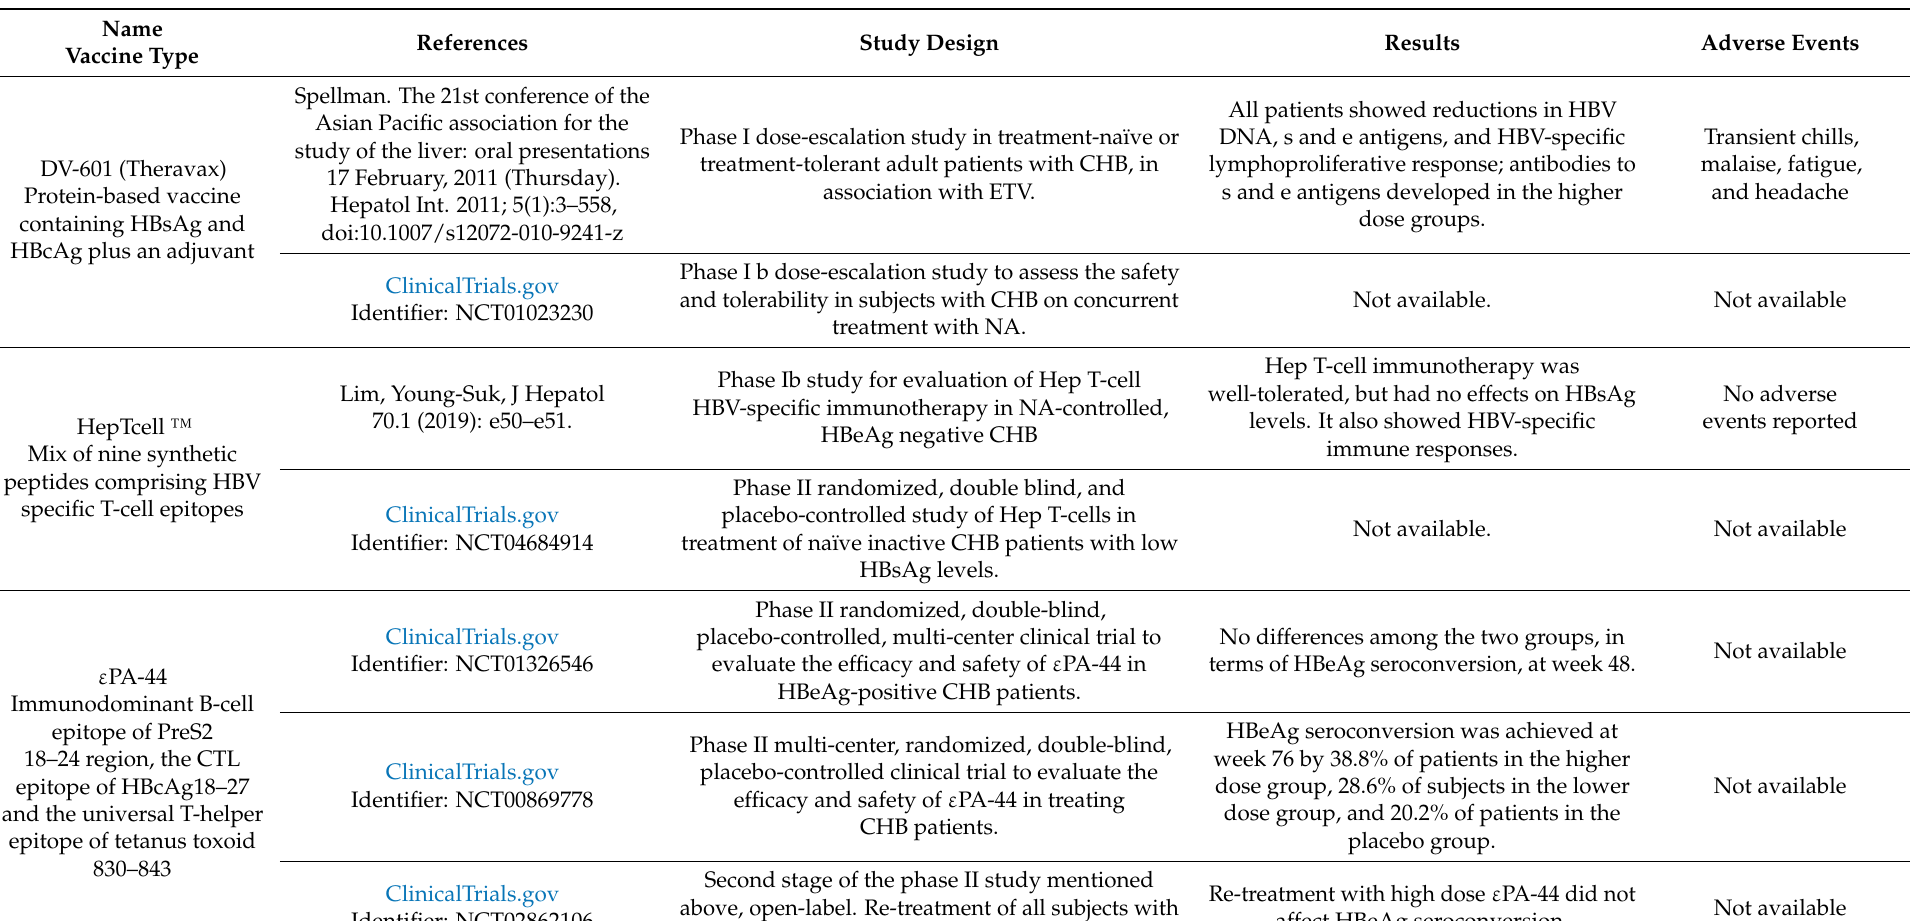
Table 3. Main clinical trials evaluating therapeutic vaccines employed in HBV chronic infection therapies. HBsAg: hepatitis B surface antigen; HBcAg: hepatitis B core antigen; CHB: chronic hepatitis B; ETV: entecavir; NA, NUC: nucleos(t)ide analogue; HBV: hepatitis B virus; DNA: deoxyribonucleic acid; HBeAg: hepatitis B early antigen; HBx: hepatitis B virus x protein; IL-2: interleukin-2; IL-12: interleukin-12; ALT: alanine aminotransferase; CD4+: cluster of differentiation 4+; CD8+: cluster of differentiation 8+; INF- γ : interferon- γ ; TGF- β